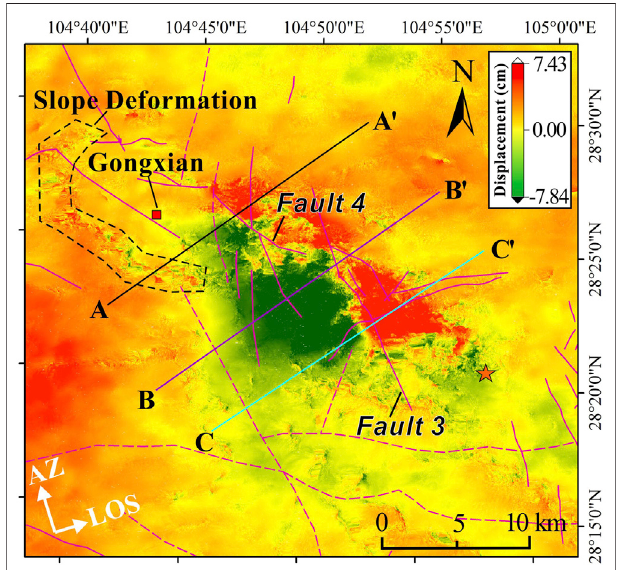
FIGURE 3 | Coseismic displacement fi eld caused by the “ 6.17 ” Ms 6.0 Changning earthquake from Sentinel-1A ascending orbit InSAR data. The maximum positive and negative LOS displacements are 7.43 and 7.84 cm, respectively.